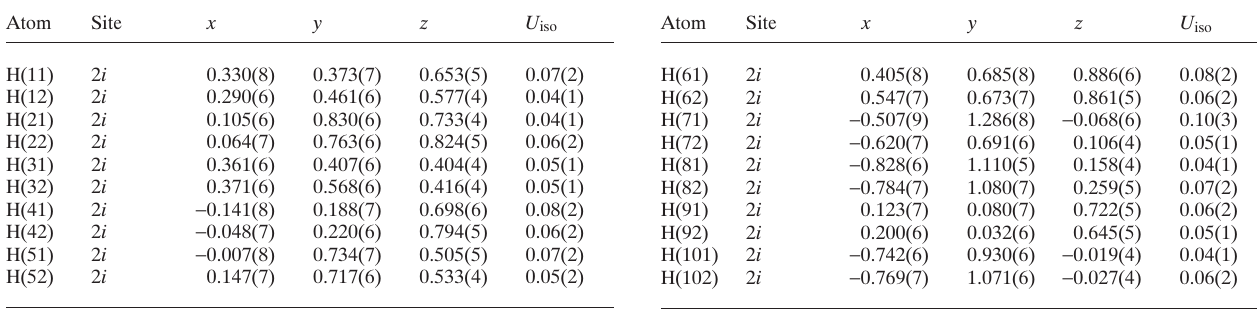
Table 2. Atomic coordinates and displacement parameters (in Å 2 )